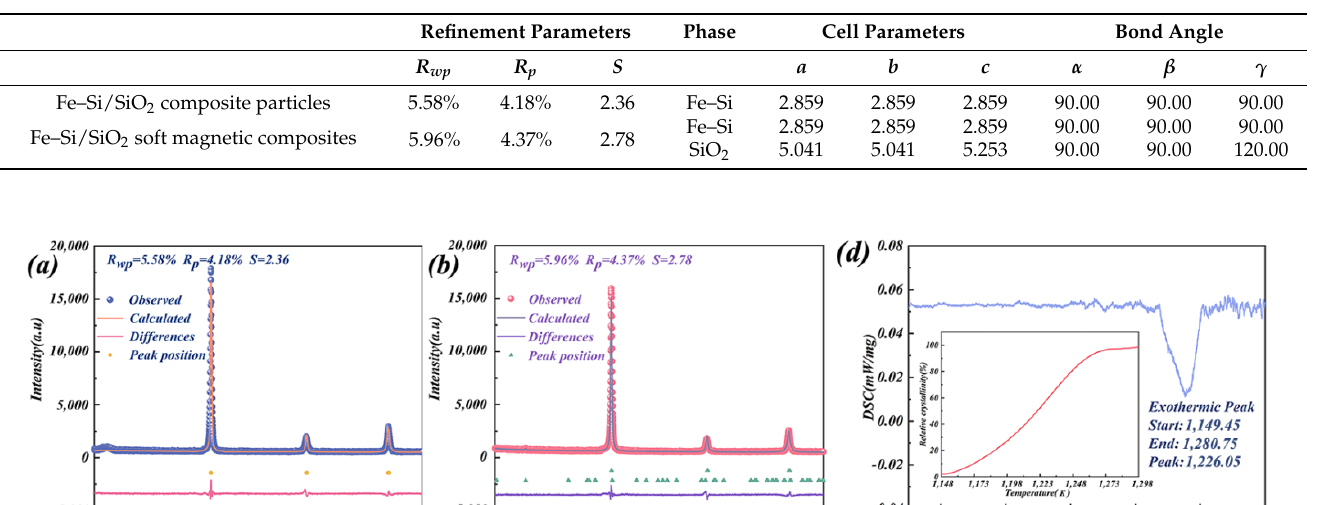
Table 1. Crystal refinement data of Fe–Si/SiO 2 composite particles and soft magnetic composites.